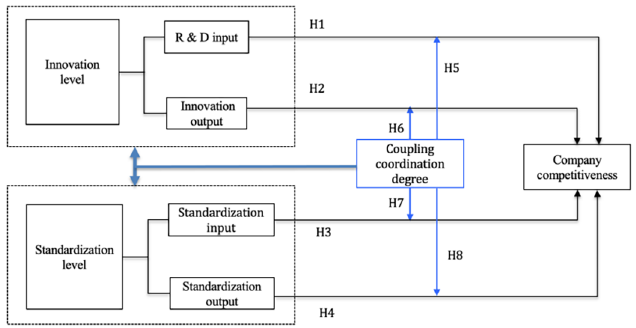
Figure 2. Theoretical